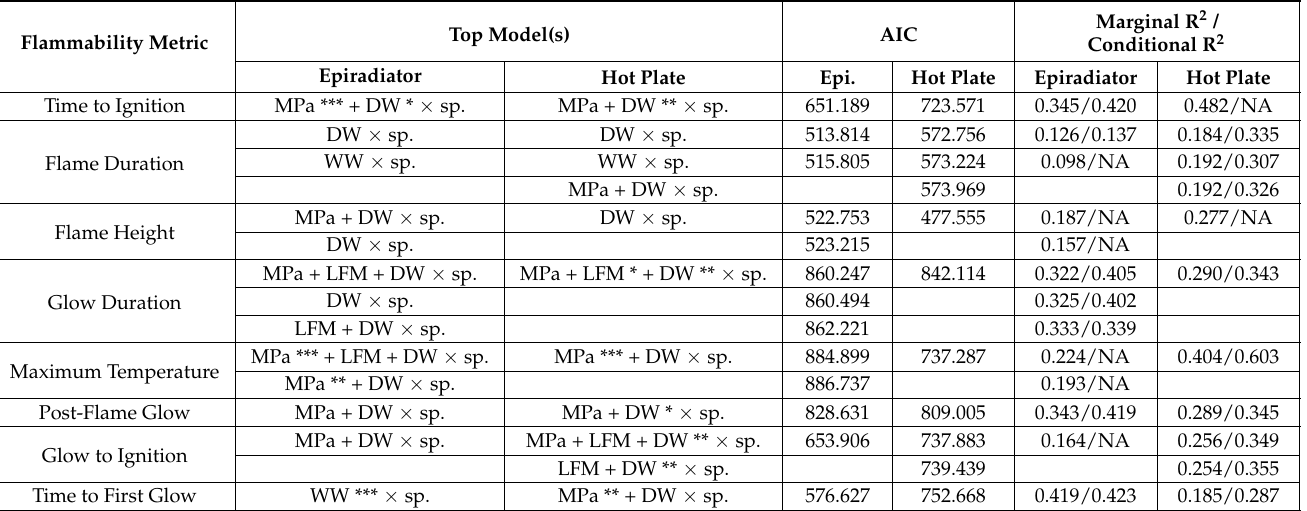
Table 1. A summary table of the primary linear mixed effects model selection. The top models are presented for each method. Significance is indicated by asterisks (*** p < 0.001, ** p < 0.01, * p < 0.05, as determined by a Kenward–Roger approximation of p -value using lmerTest [41]). R 2 values are determined using Nakagawa’s marginal and conditional R 2 for mixed effects models; NA values for the conditional R 2 occur when the variance of random effects was equal to zero on some occasions [43]. Predictors are abbreviated as follows: live fuel moisture (LFM), water potential (MPa), dry weight (DW), wet weight (WW), and species